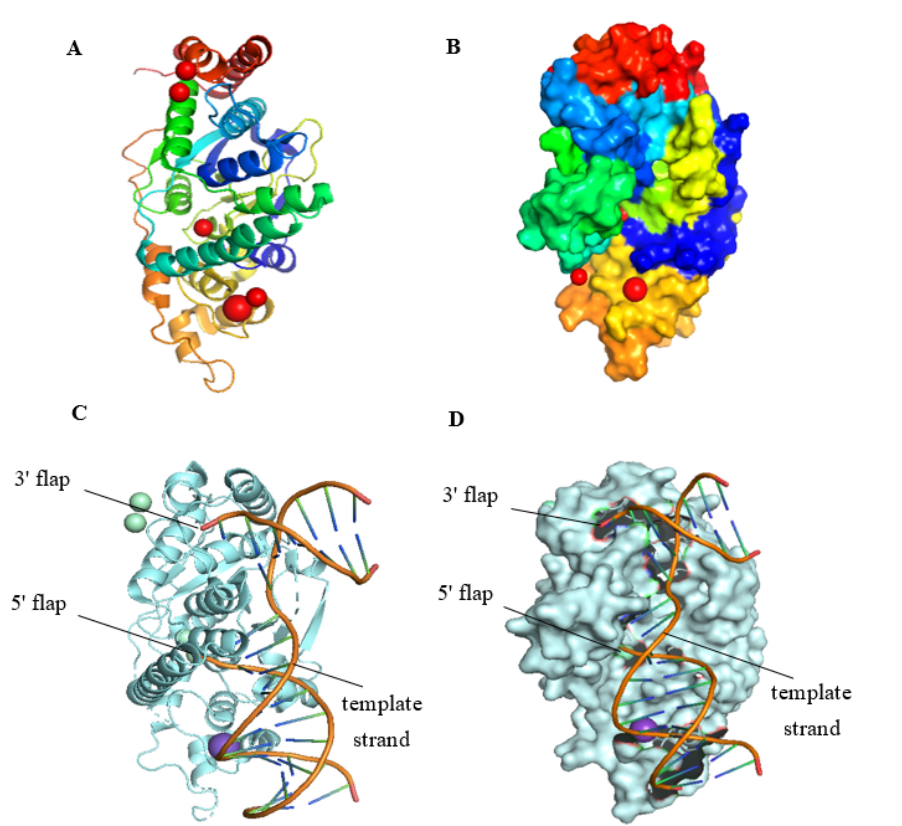
Figure 1. The structure of the hFEN1. ( A ) The published hFEN1 secondary structure (PDB ID: 5UM9). ( B ) The published hFEN1 three-dimensional structure (PDB ID: 5UM9). ( C ) The published hFEN1-DNA secondary structure (PDB ID: 3Q8L). ( D ) Superposition of double-flap DNA in the hFEN1 pre-threading structure (colored) and the published threading structure (white, PDB ID: 3Q8L). The template strand, 5 ′ flap and 3 ′ flap are labeled.